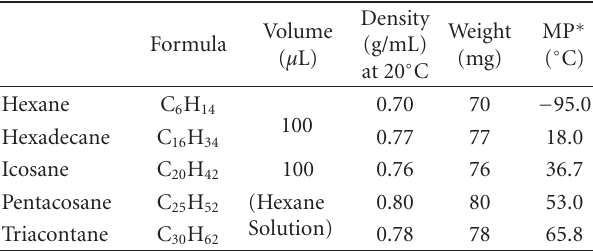
Table 1: Alkanes used for